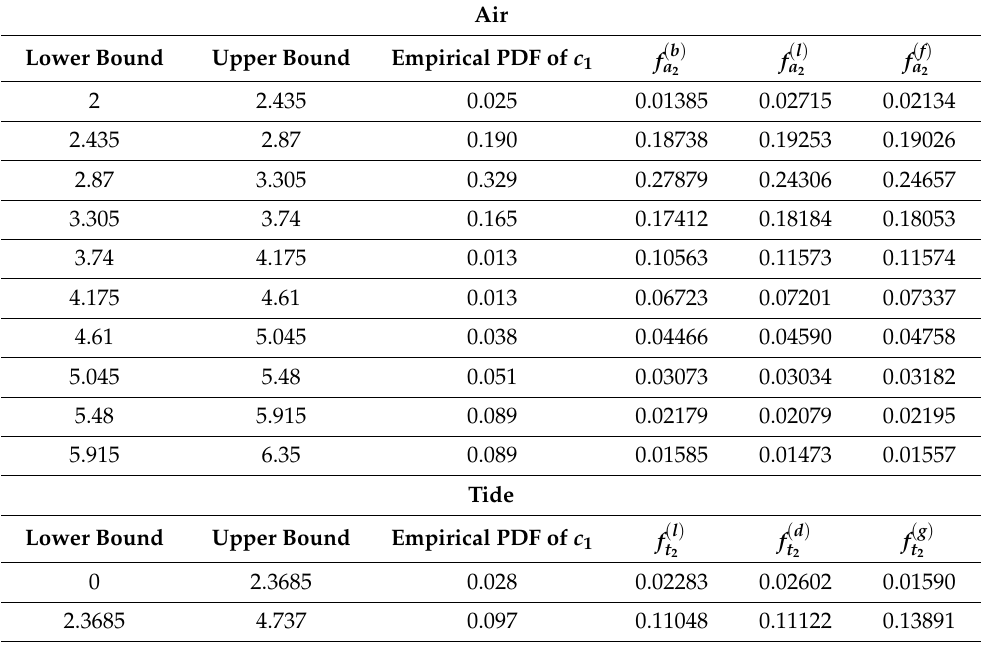
Table 13. The empirical values and the values of PDF for the three best-fitted distributions for c 1 concerning